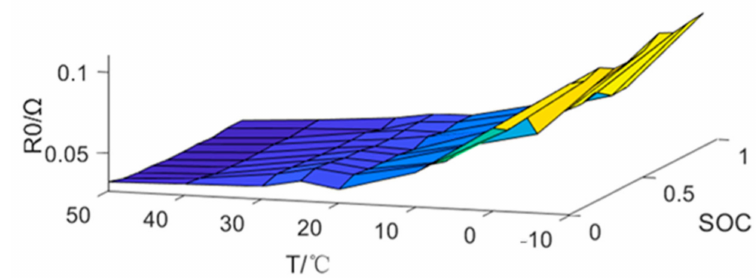
Figure 4. Ohmic internal resistance R 0 at different temperatures and SOC .